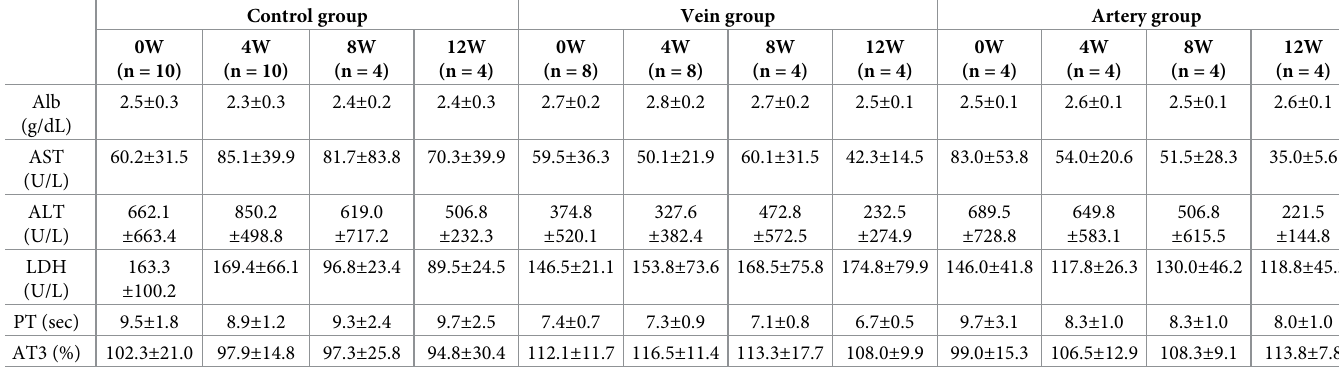
Table 1. Clinical laboratory test results.